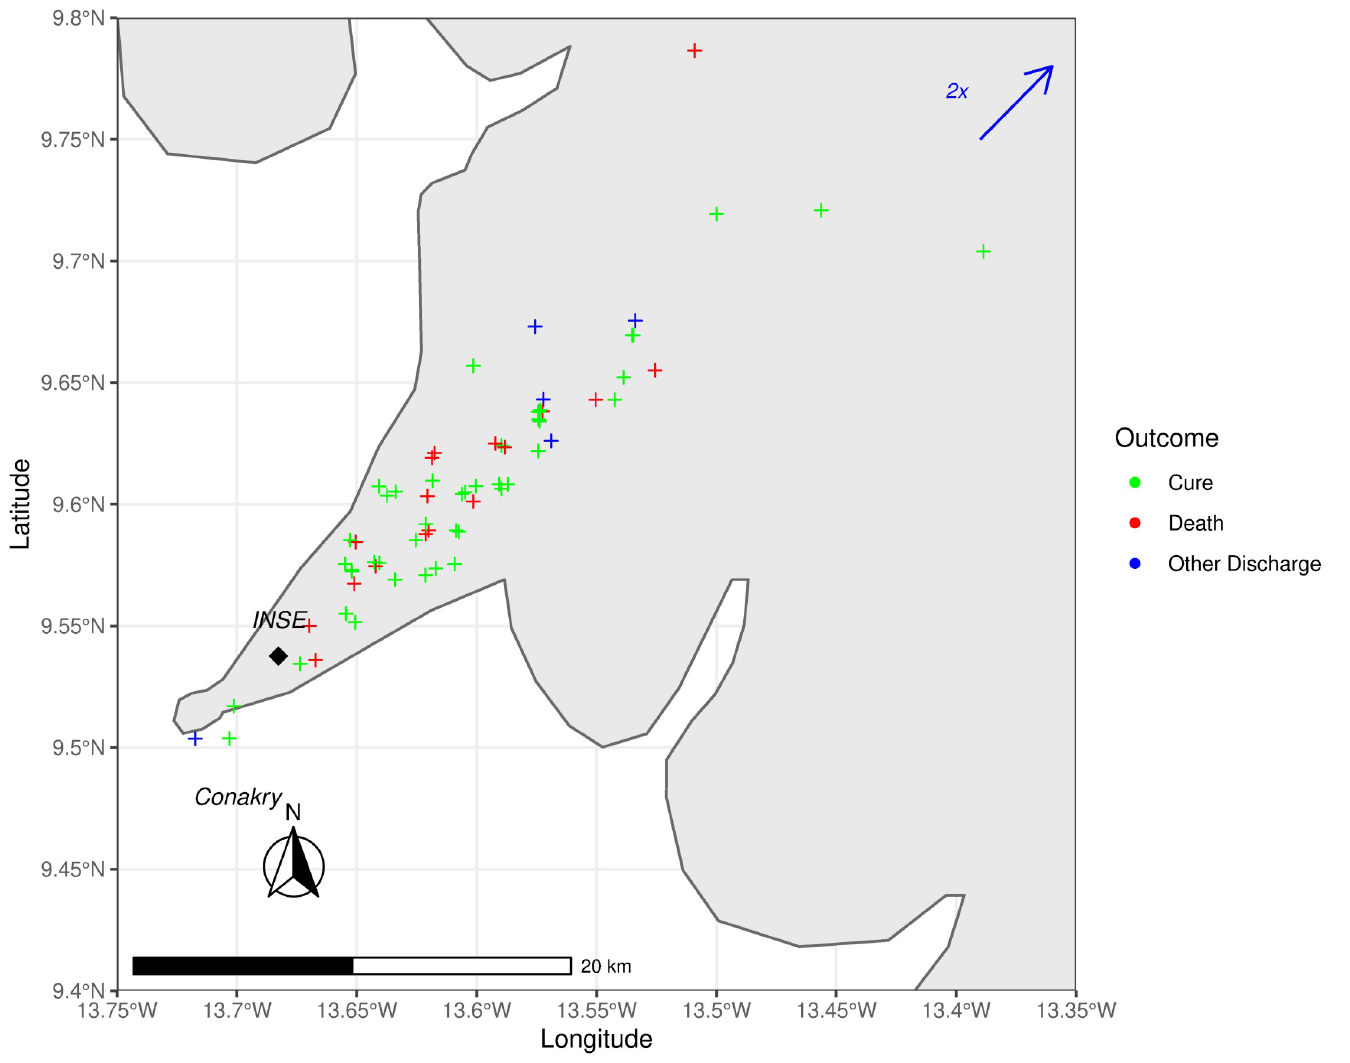
Fig 2. Map of wider Conakry showing the newborns’ points of departure before admission at INSE (black diamond) with their outcome as color-coded crosses (green = cure, red = death, blue = other discharge). Due to inaccuracies in coordinates provided by Google LLC, some crosses appear to be offshore. Two newborns (blue arrow) had a travel distance of